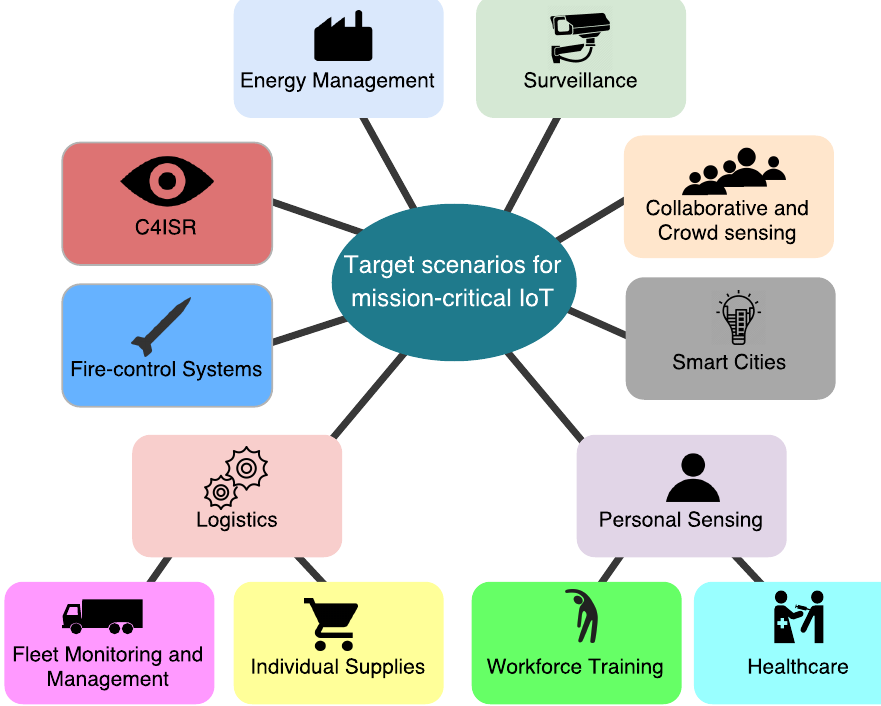
Figure 3. Promising target scenarios for defense and public